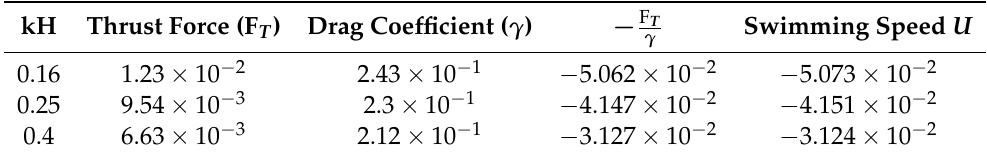
Table 2. Deformable interface ( β = 0.5): thrust force, drag coefficient, their ratio, and the simulated swimming